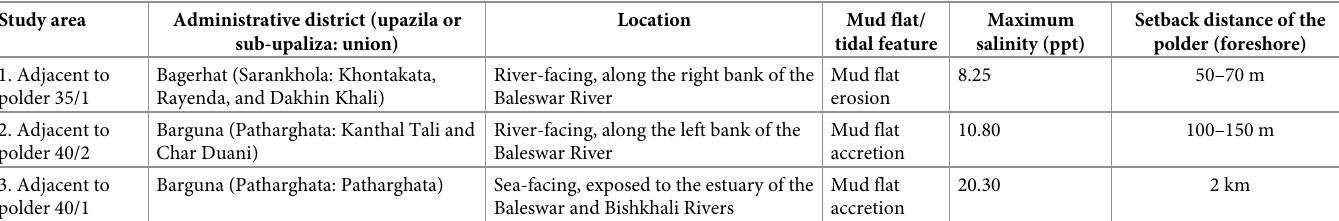
Table 1. Key characteristics of the three study